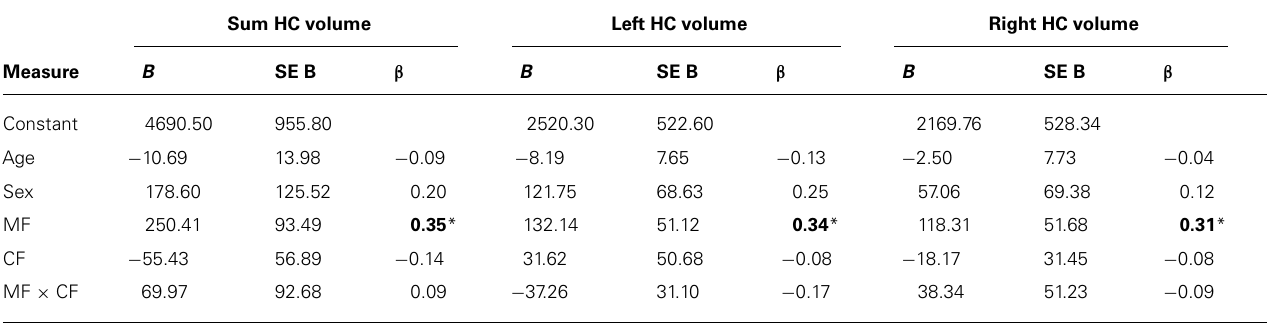
Table 3 | Regression statistics for hippocampal (HC) volume (sum HC volume: sum of left and right volume, left HC volume, right HC volume) as dependent variable and age, sex, motor fitness (MF), cardiovascular fitness (CF), and their interaction term as independent variables. Sum HC volume Left HC volume Right HC volume